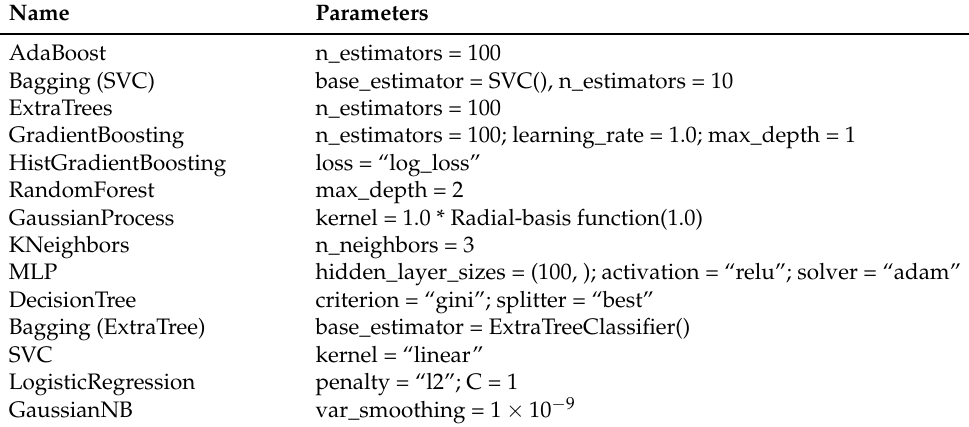
Table 5. Evaluated Classifiers.